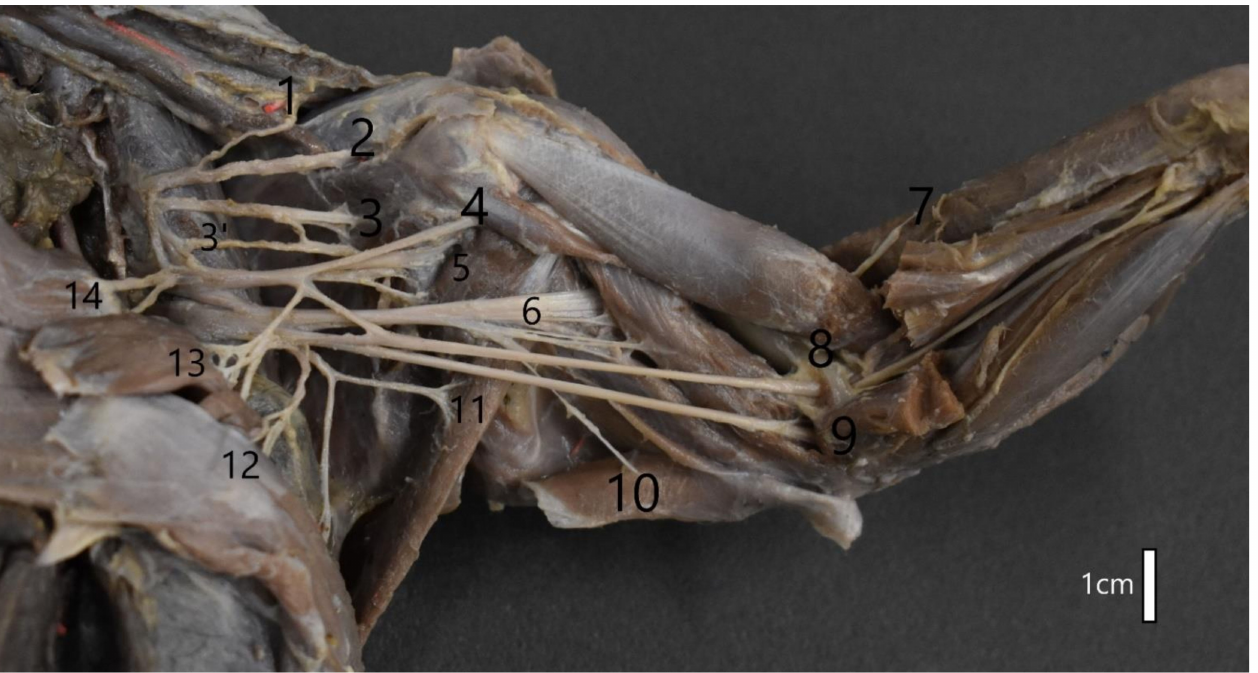
Figure 5. Structure of the left brachial plexus of the European pine marten ( Martes martes ). 1—Brachiocephalic nerve; 2—Suprascapular nerve; 3,3 (cid:48) —Subscapular nerve; 4—Musculocutaneus nerve; 5—Axillar nerve; 6—Radial nerve; 7—Medial antebrachial cutaneous nerve; 8—Median nerve; 9—Ulnar nerve; 10—Branch to tensor fasciae antebrachii; 11—Thoracodorsal nerve;